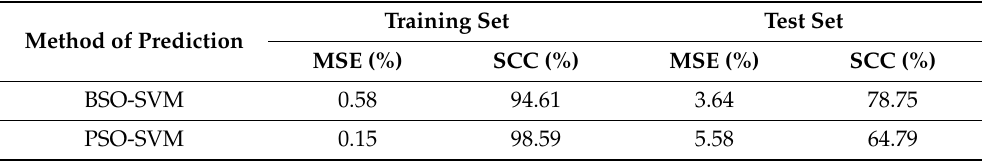
Table 3. Comparison of experimental data with different methods. Method of